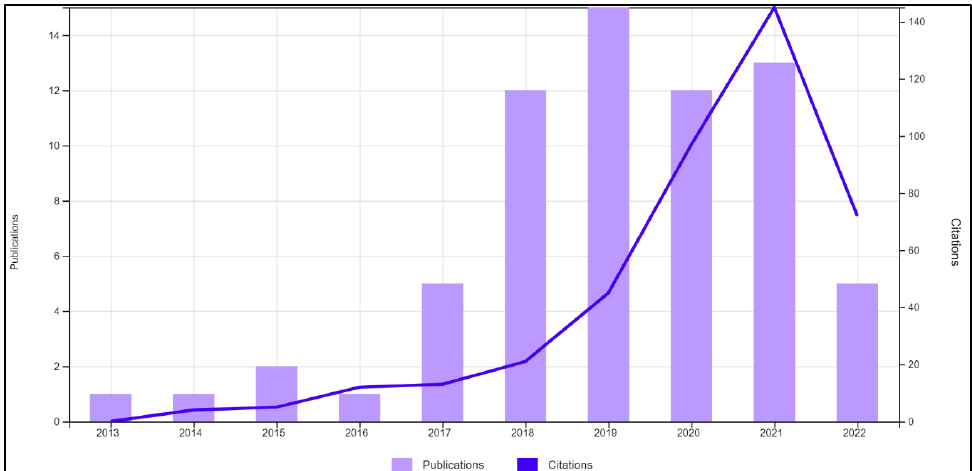
Figure 14. An Overview of publications and citations on the topic of Smart cities in Hungary. Source: own analysis as per Web of Science (2022).